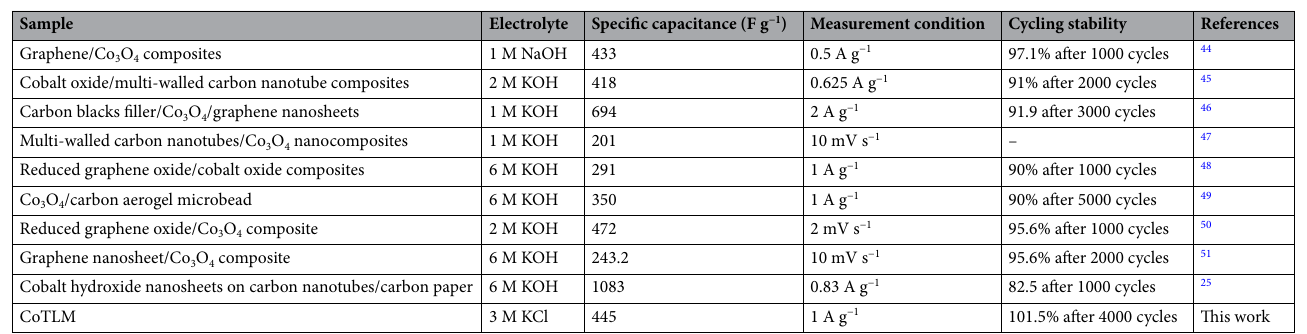
Table 2. Electrochemical results derived from cobalt-based